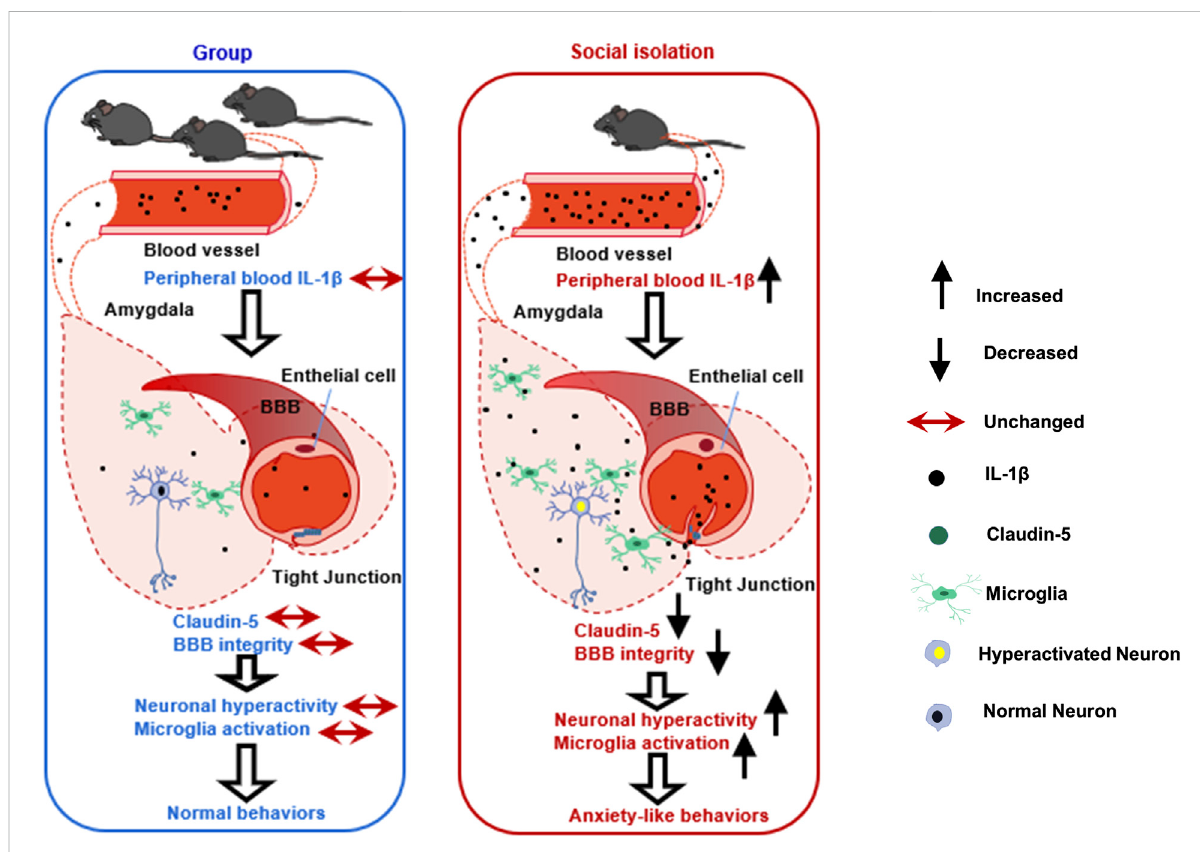
FIGURE 7 A schematic diagram outlining the mechanisms of impaired BBB in social isolation-induced anxiety-like behaviors in female mice. The left picture shows the normal BBB integrity in the amygdala in group-housed female mice without anxiety-like behaviors. The right picture shows the damaged amygdala BBB in female mice with anxiety-like behaviors after social isolation. We speculate that the possible mechanisms by which female mice experienced social isolation are more susceptible to anxiety is that social isolation-induced peripheral cytokine IL-1 β in fi ltrating into the brain parenchyma, further promoting local BBB leakage, increasing neuroin fl ammation, and triggering neuronal activation in the